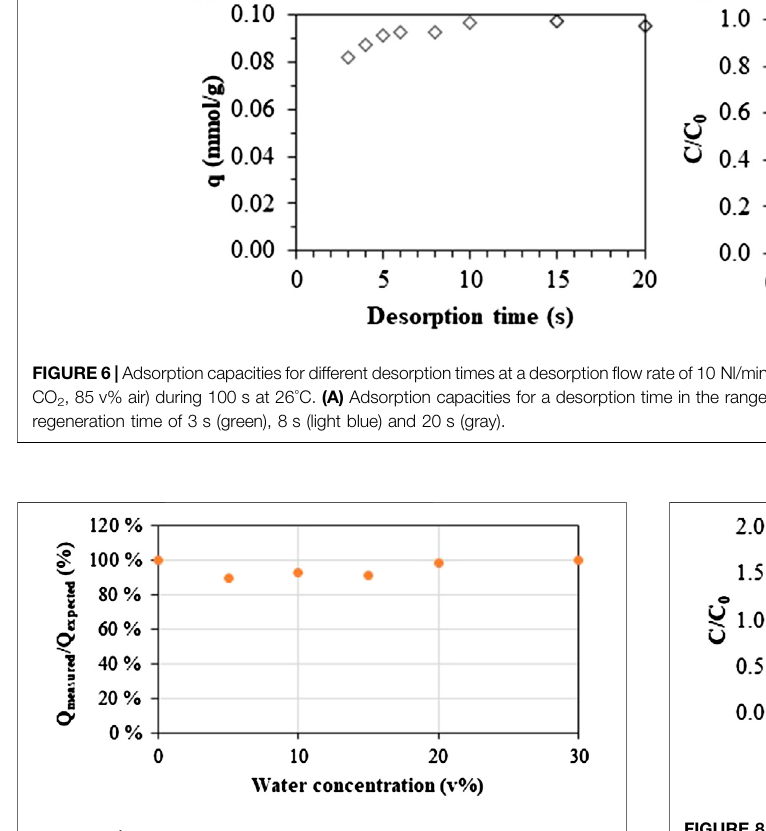
FIGURE 7 | Ratio of the adsorption capacity calculated from the breakthroughcurvedividedbytheadsorptioncapacityexpectedforaspeci fi c relative pressure of CO 2 from the dynamic isotherm ( Figure 4 ) in function of a different water concentration in the feed stream (More details in Supplementary Material ).